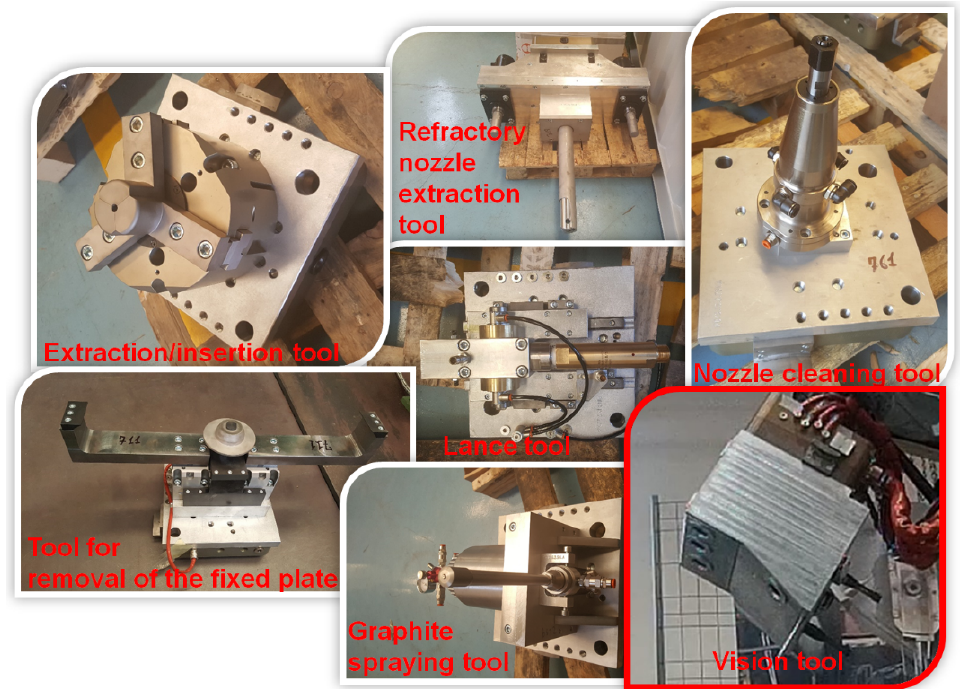
Figure 3. Overview of the different tools handled by the robot: The vision tool is highlighted in red.